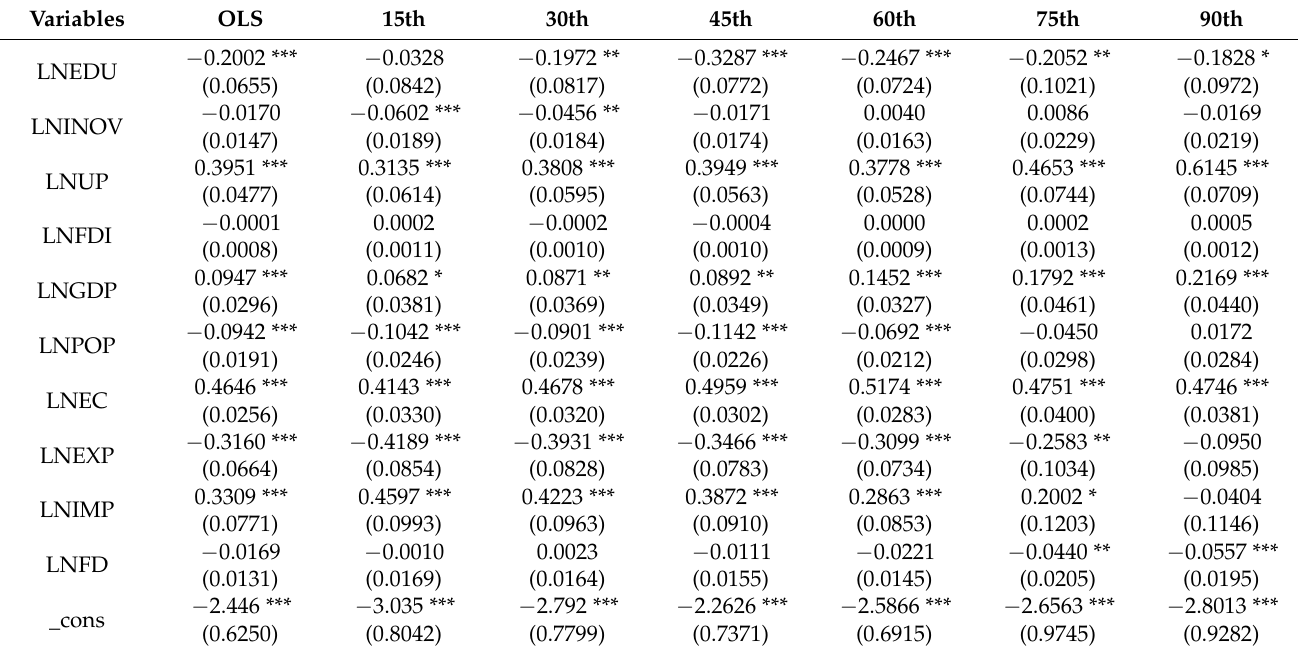
Table 6. Quantile Regression Results (High Income Countries).